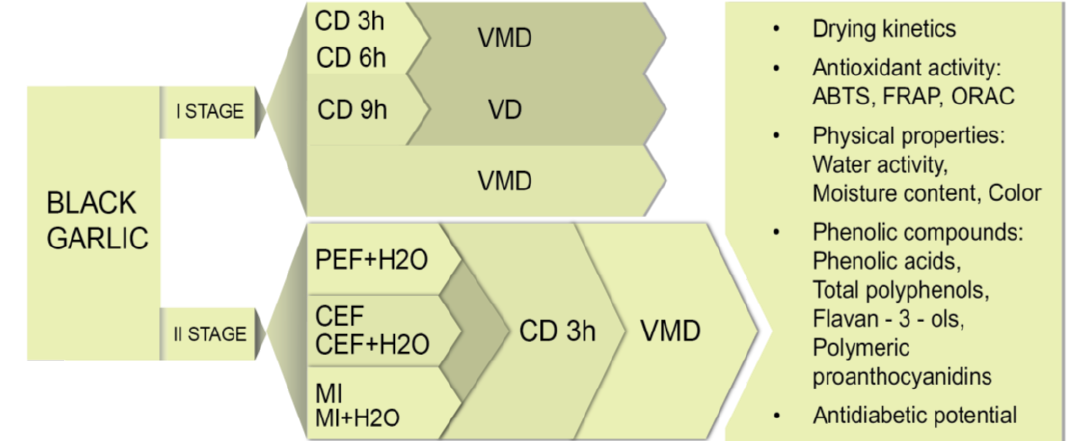
Figure 5. Schematic representation of the two stages of experiments performed in this study and analyses performed in this study. CD — convective drying; VMD — vacuum-microwave drying; VD — vacuum drying; PEF — pulsed electric field; CEF — constant electric field; MF — magnetic field.